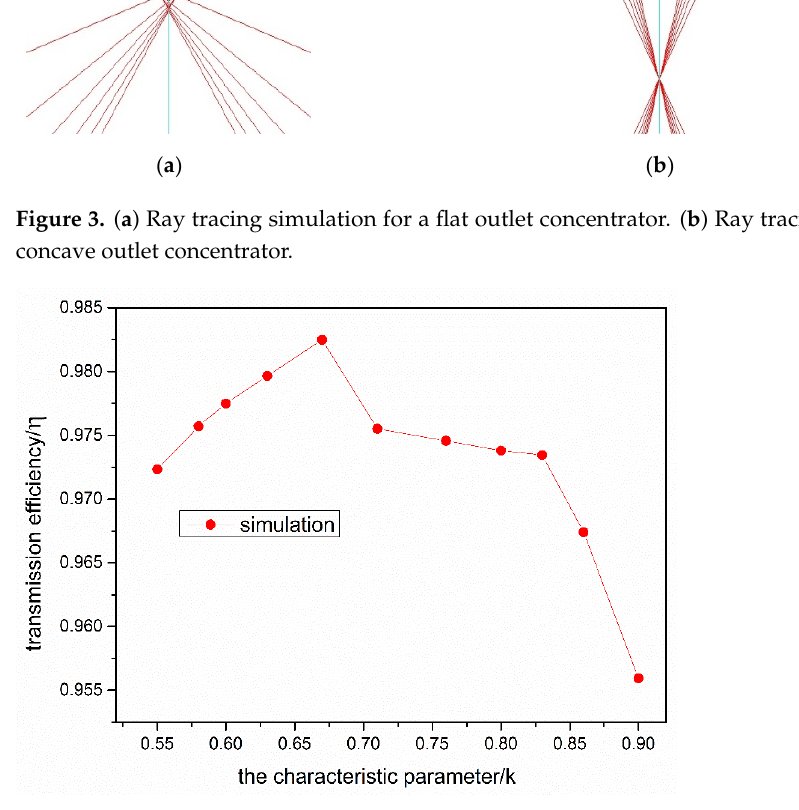
Figure 4. Variation curve of light transmission efficiency with characteristic parameters.